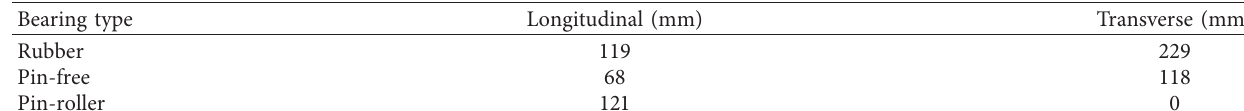
Figure 11: Displacement ductility demands of bents with different bearing types. (a) Longitudinal direction. (b) Transverse direction. Table 4: Maximum seismic displacement of bearings for different bearing types.